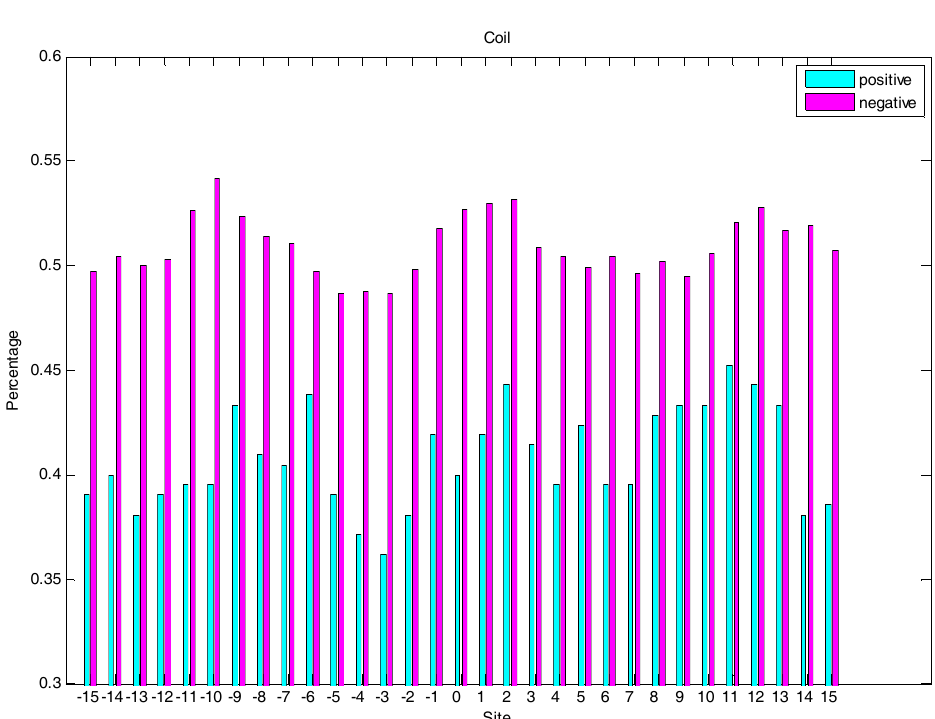
Figure 4. The distribution of coil structures of residues around glycation and non-glycation sites.